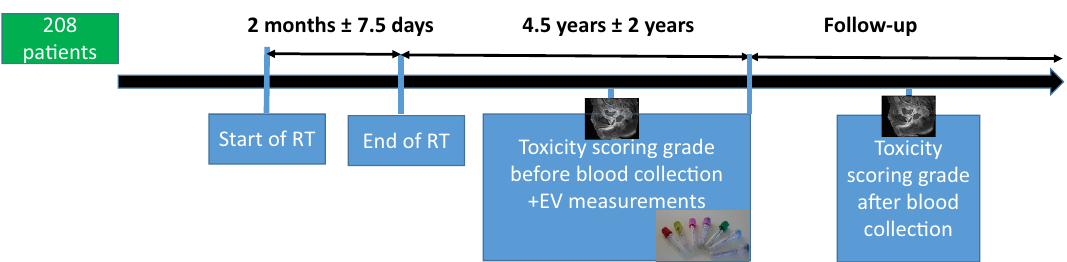
Figure 1. Main steps of the EPINAL study protocol. Blood samples were collected for circulating biomarkers analysis in the years following the end of the RT; toxicity scoring was performed at the time of blood collection and during